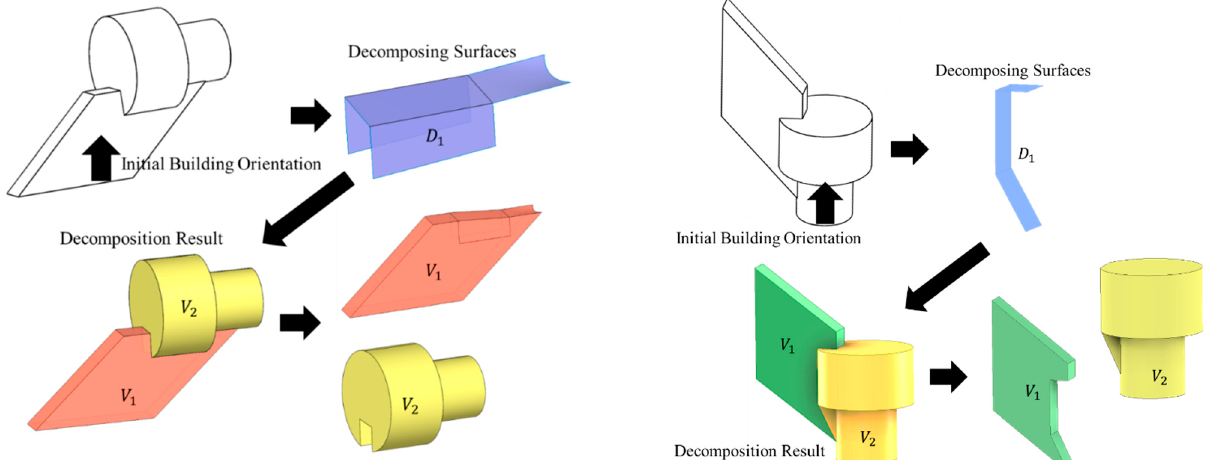
Figure 8. Decomposed single ‐ body features of identical part by applying different initial orientation.